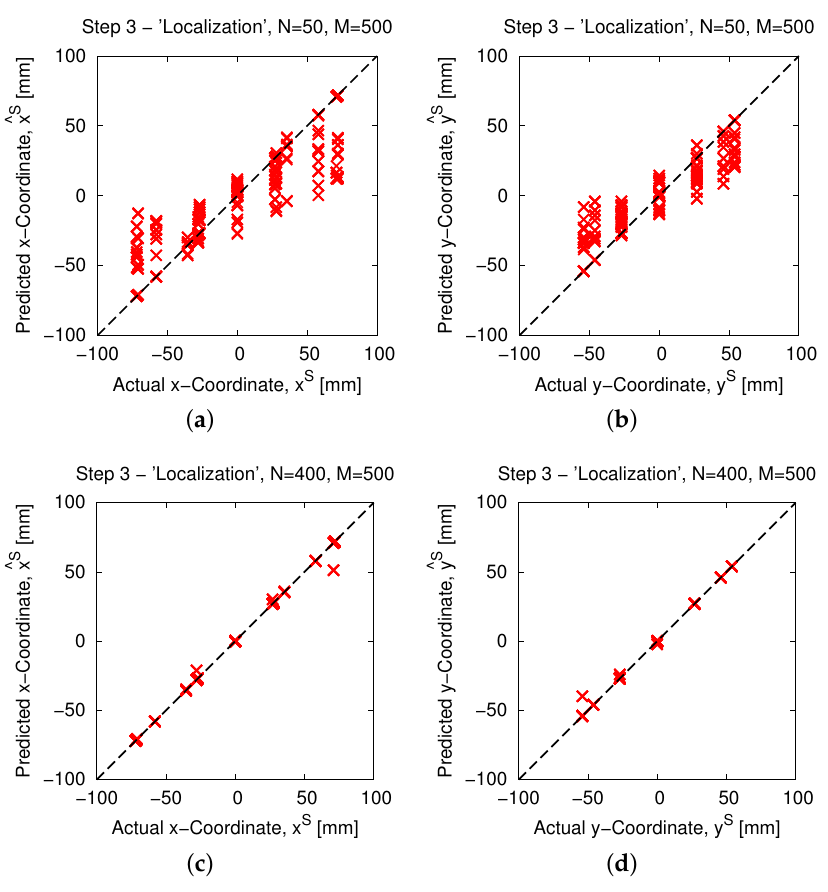
Figure 10. Experimental Assessment. ( V = 8, f 0 = 900 MHz, (cid:101) ε B = 41.8 ε 0 − j 0.97 j 0.85 , (cid:101) ε S H = 48.63 ε 0 − j 1.28 , M = 500, P = 25)—Actual vs. predicted ( a , c ) x -coordinate and ( b , d ) 2 π f 0 2 π f 0 y -coordinate of the stroke when solving Step 3 (“Localization”) though a SVR approach with ( a , b ) N = 50 and ( c , d ) N = 400 training samples.